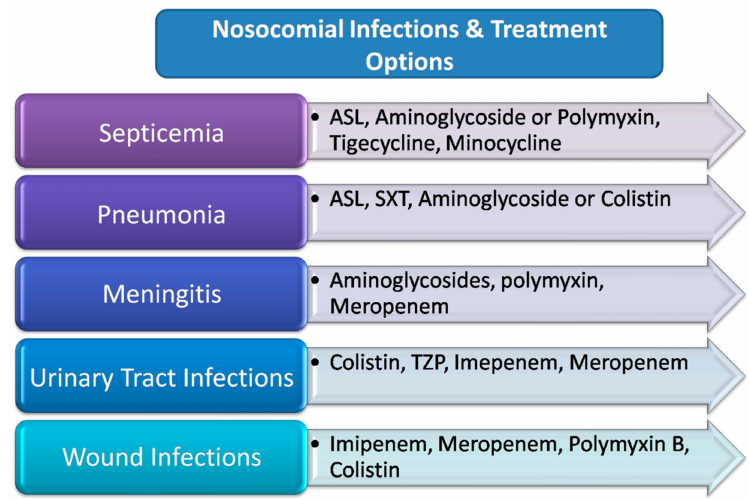
Figure 3. Therapeutic treatment options for nosocomial infections of A. baumannii